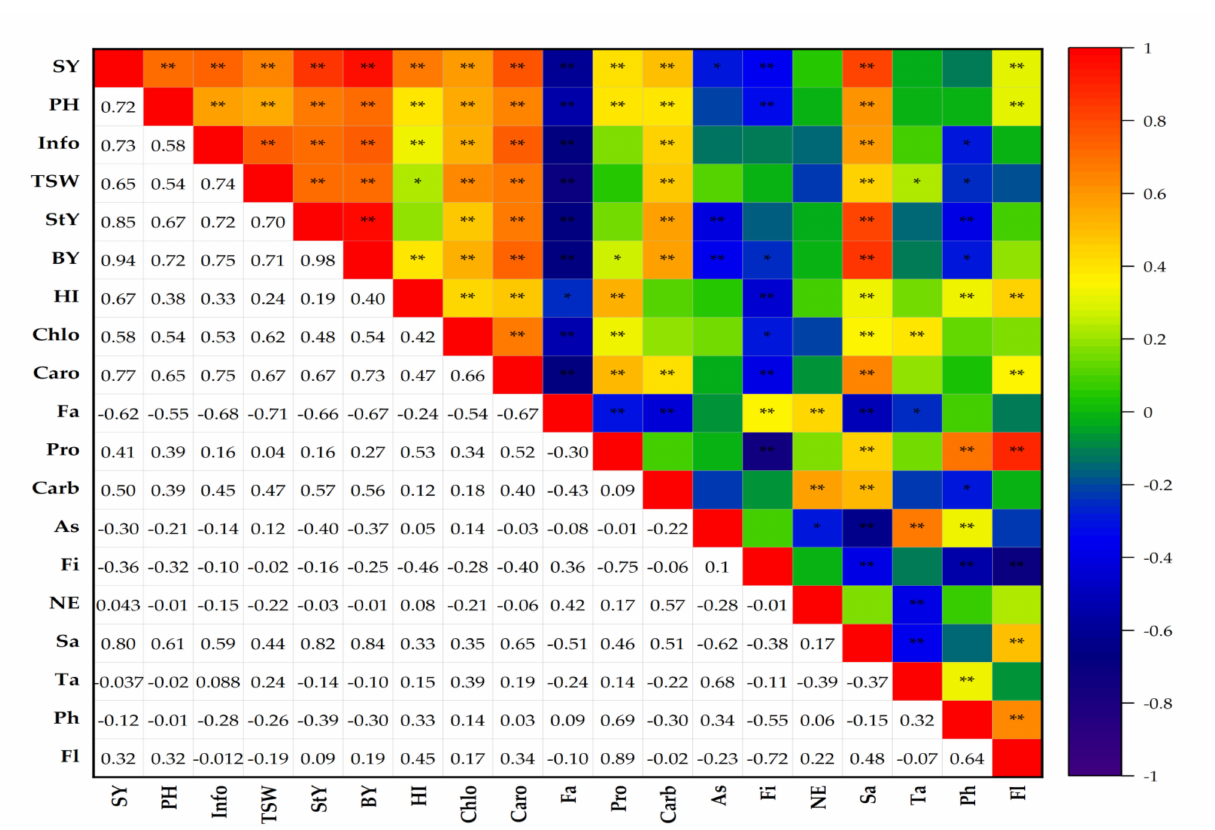
Figure 8. Matrix of Pearson’s correlation coefficients and correlation plots for studied traits. Pearson’s correlation coefficients are presented in the bottom-left half. The correlation plots are presented in the upper right half. The colors of the boxes represent positive or negative correlations according to a color scale. P -values below 0.05 and 0.01 are expressed as * and **, respectively. Seed yield (SY), plant height (PH), inflorescences number plant (Info), 1000-seed weight (TSW), straw yield (StY), biological yield (BY), harvest index (HI), total chlorophyll (Chlo), carotenoids (Caro), fats (Fa), ash (As), fiber (Fi), nutritional energy (NE), saponin (Sa), tannins (Ta), phenolics (Ph), and flavonoids